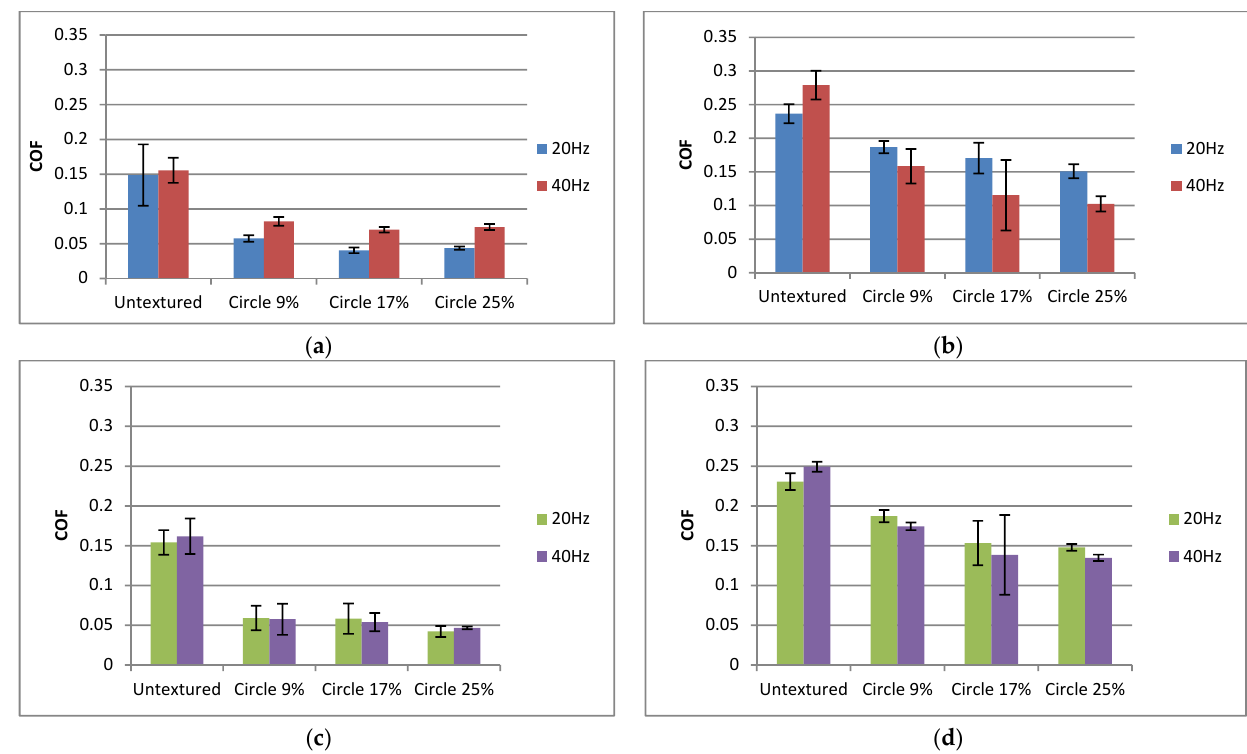
Figure 12. Average values and standard deviations of the coefficient of friction of textured and untextured sliding pairs for the following operating conditions: p = 40 N, T = 30 °C ( a ); p = 40 N, T = 80 °C ( b ); p = 80 N, T = 30 °C ( c ); p = 80 N, T = 80 °C ( d ) .